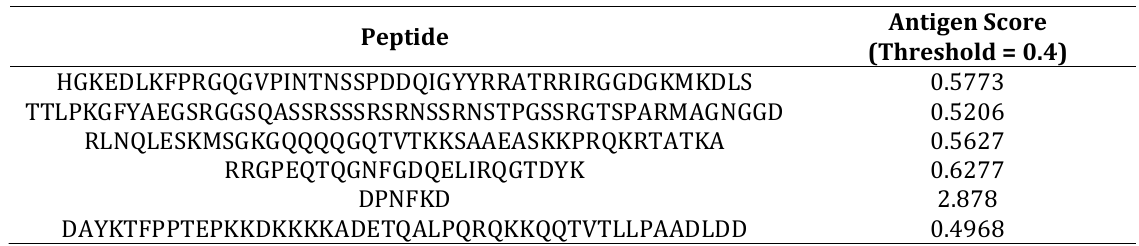
Table IIb. List of peptides that have the antigen properties and qualifies for the molecular docking process with human BCR/FAB Receptor.